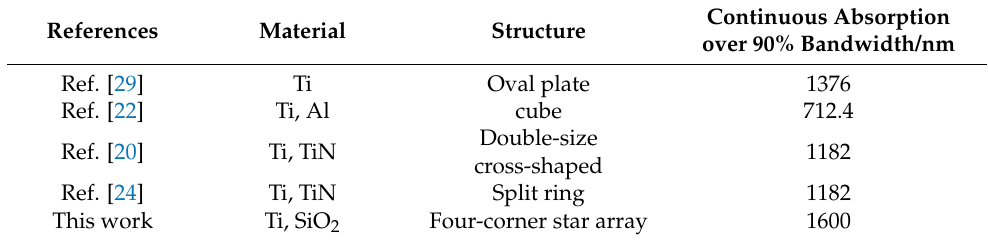
Table 2. Comparison of some absorbers with the absorber proposed in this